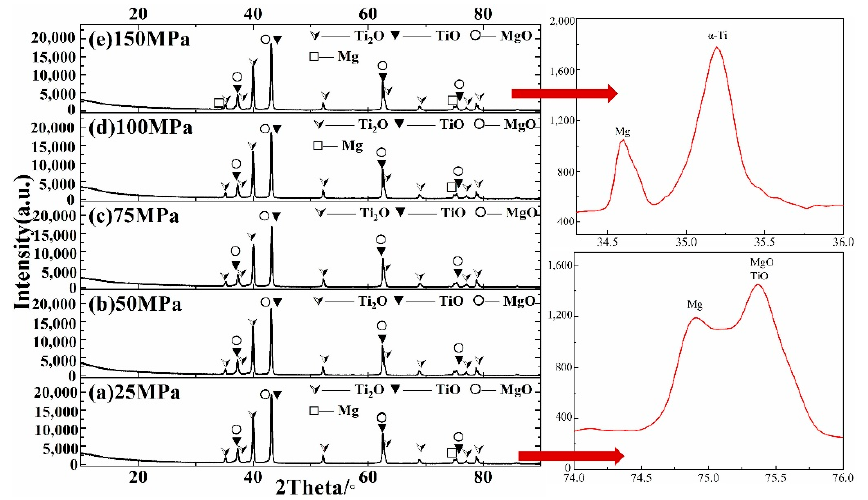
Figure 2. XRD patterns for SHS products of the Mg-TiO 2 system at different sample preparation pressures